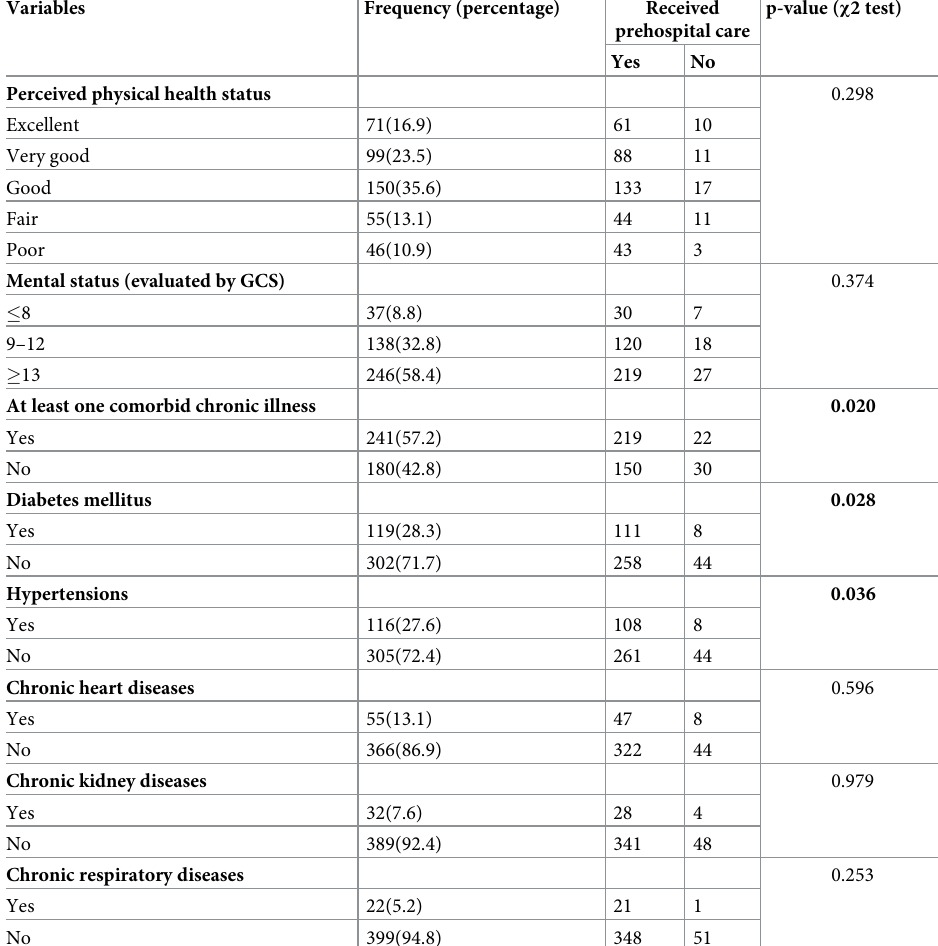
Table 4. Description of prehospital care utilization by need factors among severe and critical COVID-19 patients who visited treatment centers in Addis Ababa, Ethiopia, from May to July 2021. Variables